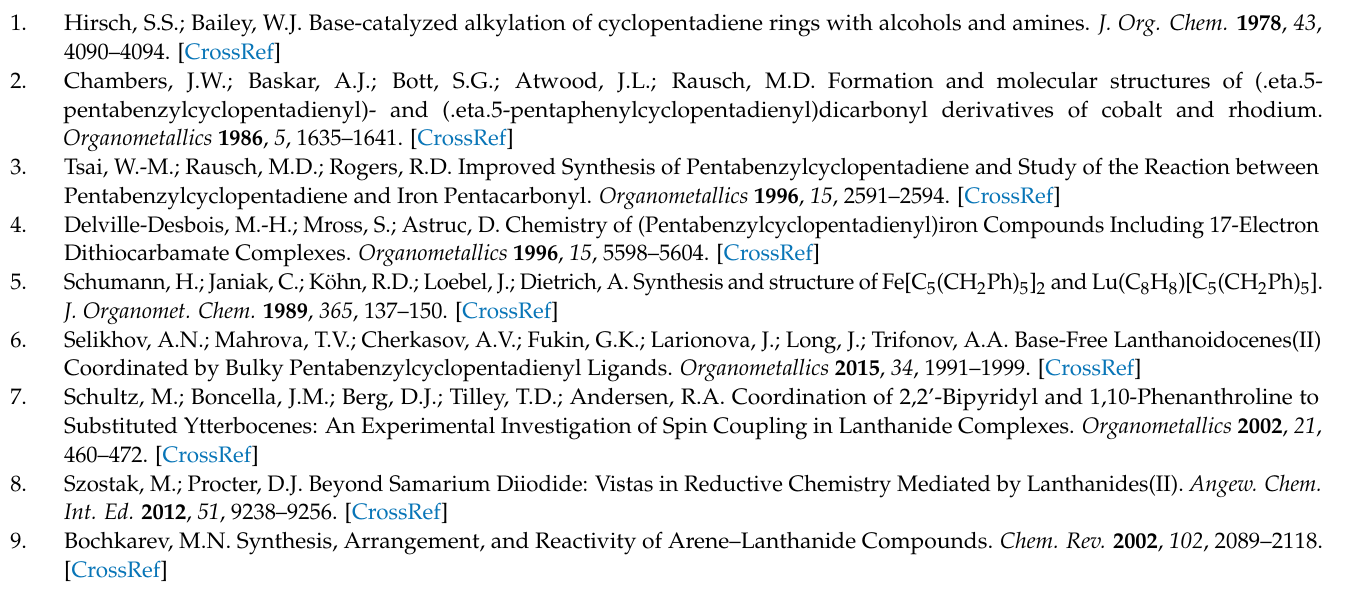
Table S1: Crystal data and structure refinement of 1 , 2 , 3 and 4